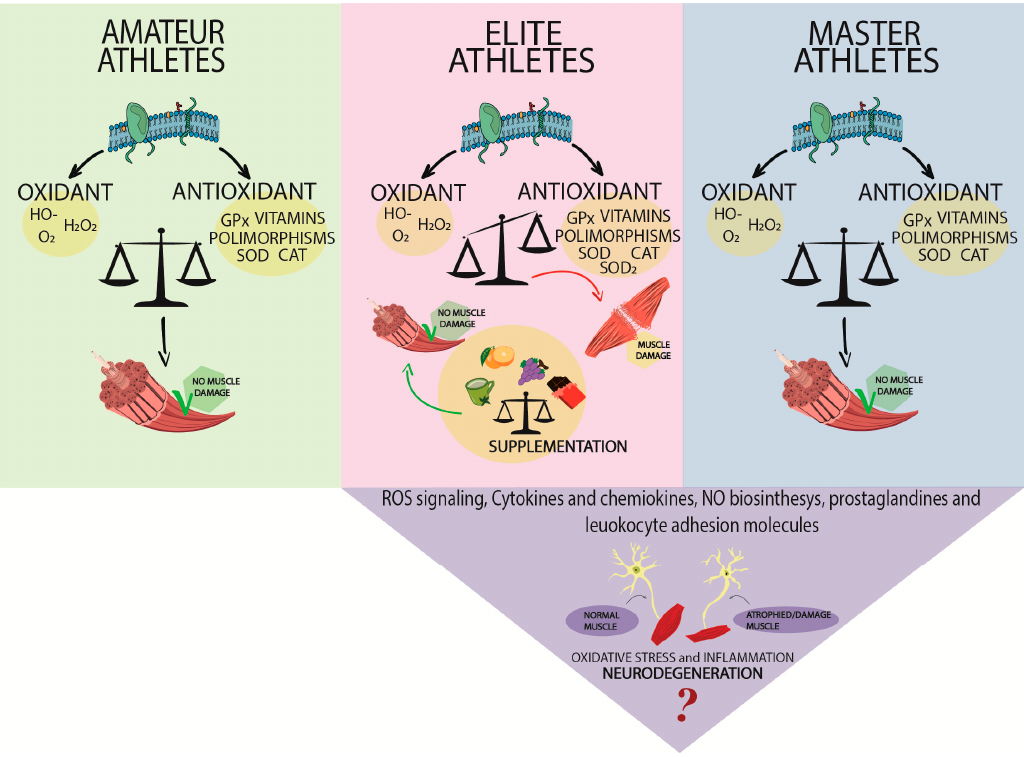
Figure 1. Schematic representation of the redox balance in three classes of athletes: amateur, elite, and master. High intensity exercise causes a redox imbalance that leads to di ff erent types of injuries, muscle damage, and development of neurodegenerative diseases. Furthermore, supplementation with antioxidants could restore the redox balance and reduce tissue damage mediated by oxidative stress in elite